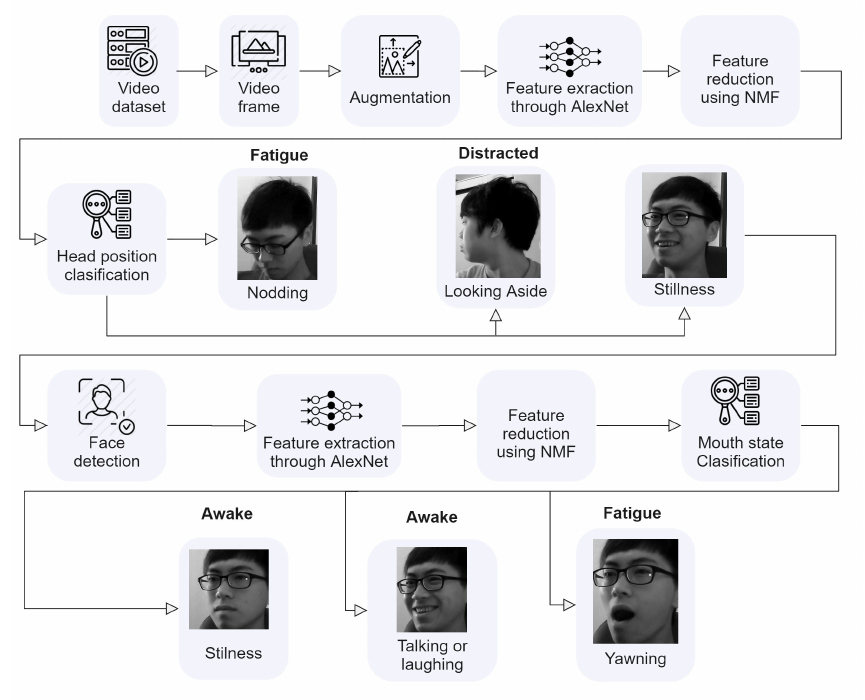
Figure 1. Overview of the proposed